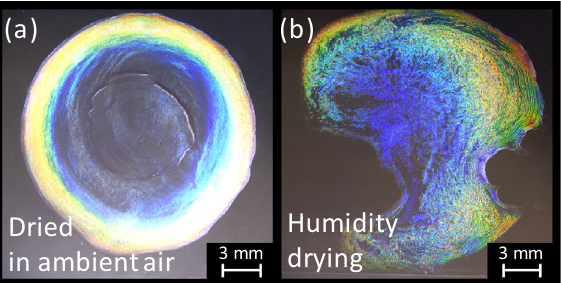
Figure 3. Comparison of two initial CNC droplets dried ( a ) in the ambient air and ( b ) under high humidity of approximately 70–80%. These droplets were made using the 7% CNC suspension. These images were acquired in reflection mode under white light without